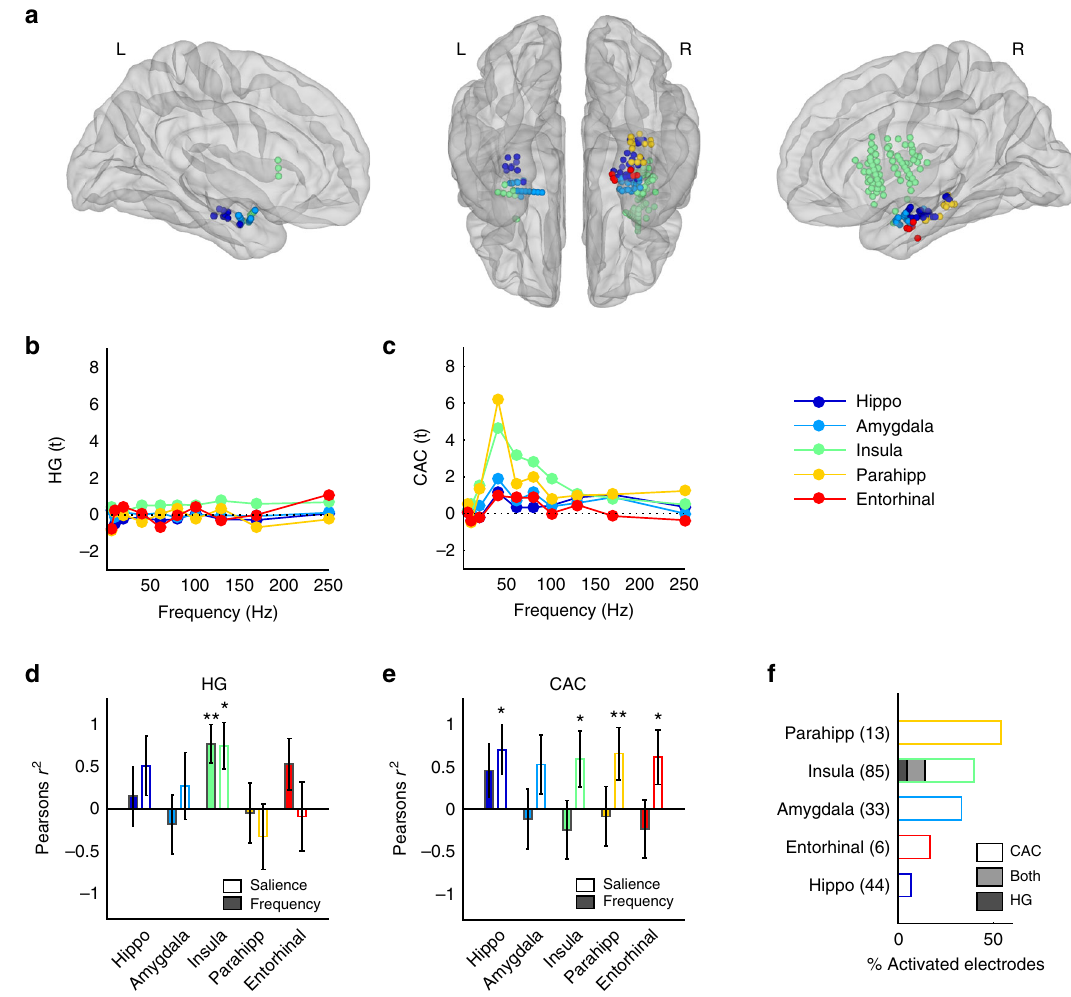
Fig. 4 HG and CAC response patterns in subcortical and limbic regions. a Anatomical and functional categorisation of electrodes in subcortical nuclei and limbic regions, based on the Desikan-Killiani anatomical parcellation. Left: left hemisphere, medial view. Centre: ventral view. Right: right hemisphere, medial view. b HG responses (expressed in t-values relative to the baseline) averaged within regions and across participants at each stimulus frequency. c Same as in b. for CAC. d Pearson correlation value ( r 2 ) between onset HG responses and stimulus frequency (colour- fi lled bars) and salience (empty bars). Error bars indicate SE of the correlation. e Same as in ( d ) for CAC. f Proportion of activated electrodes exhibiting signi fi cant HG onset response (dark shading), sustained CAC (no shading) or both (grey shading) in each region. Numbers on the y-axis indicate the number of electrodes located in each region. *, ** indicate signi fi cant (corrected) p -values at 0.05, 0.01, respectively. Hippo Hippocampus, Parahipp Parahippocampal